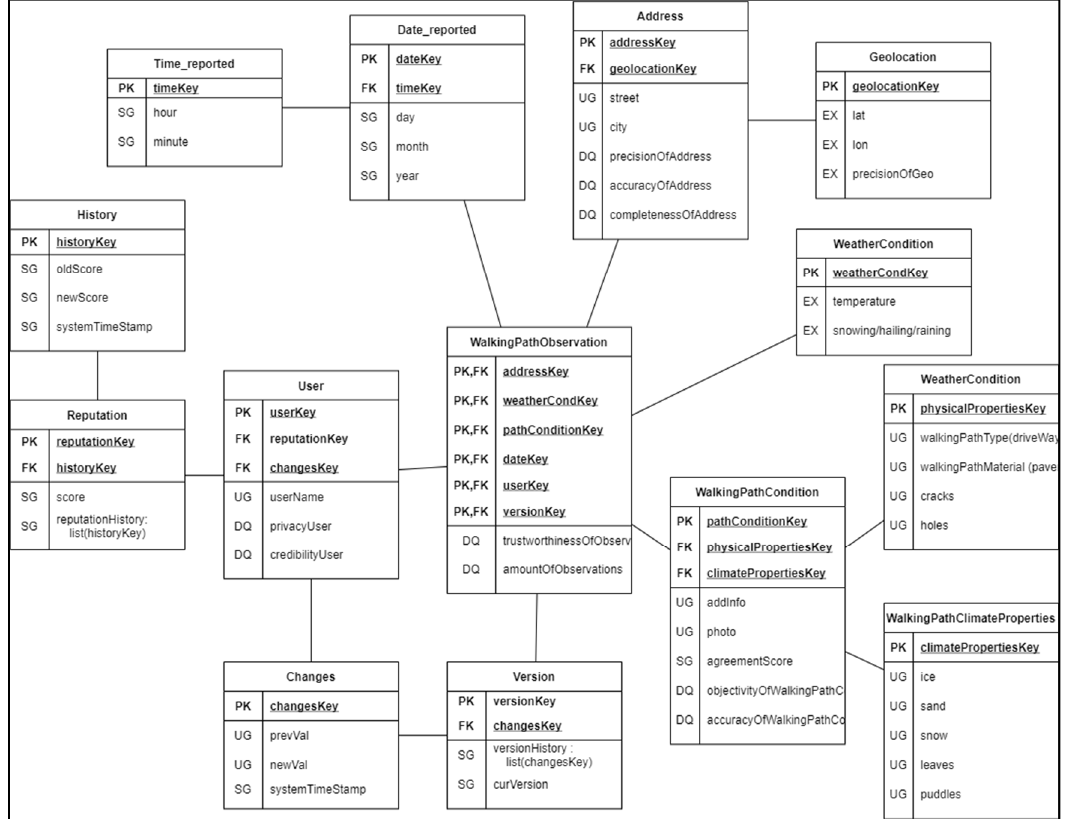
Figure 1. A database schema using the snowflake model for WalkingPaths.